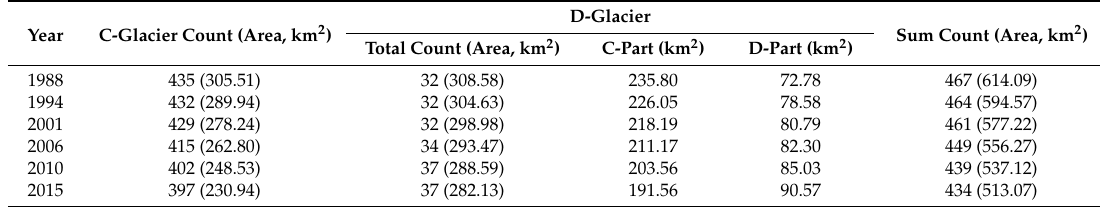
Table 2. Statistics of glacier inventories in six episodes between 1988 and